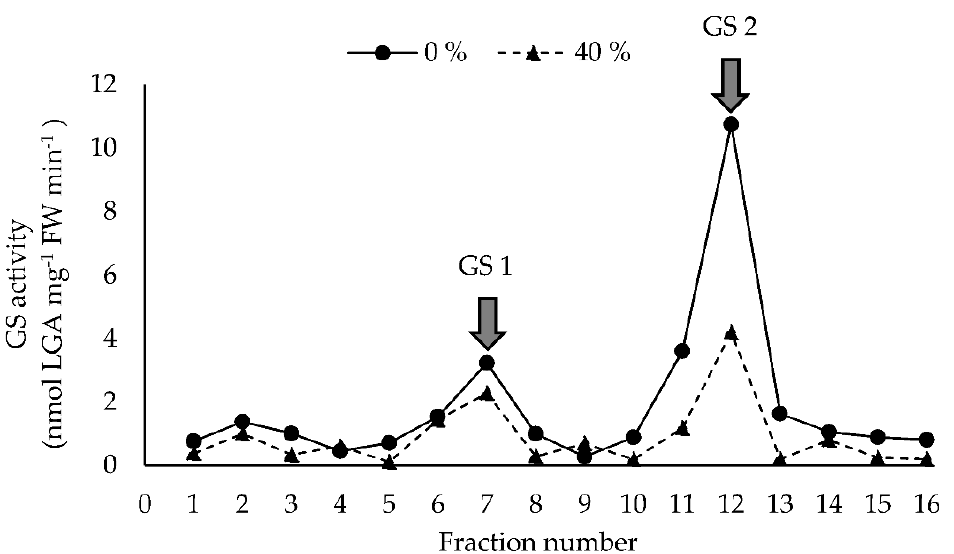
Figure 6. Cytosolic (GS1) and plastidic (GS2) GS activity of the youngest and second youngest fully expanded leaves of spring wheat (cv. Amaretto) foliar fertilized with 0% N or 40% N UAN solution at 6 HAFNf.